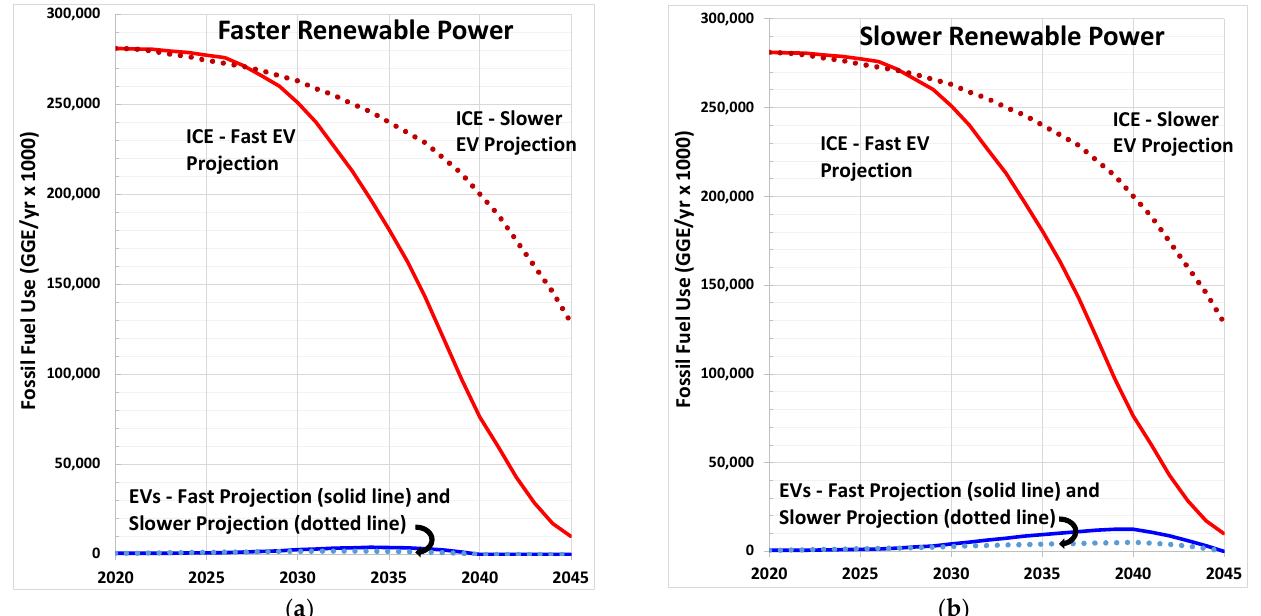
Figure 14. Total Passenger vehicle fossil fuel use showing the impact of the faster EV projection (solid lines), and slower EV projection (dotted lines): ( a ) Fast renewable power projection; ( b ) Slower renewable power projection.